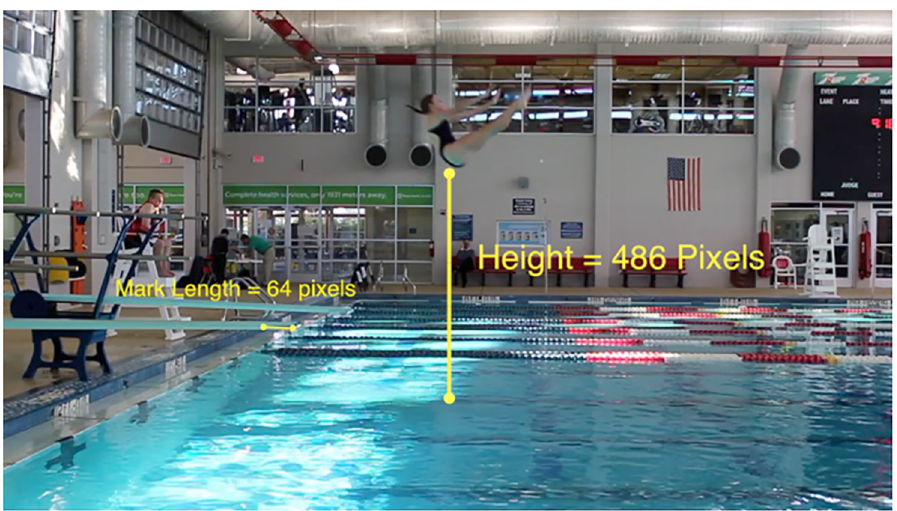
Fig 2. Measuring height of the dive. Still photo illustrating how height of the dive was measured from the recorded footage.